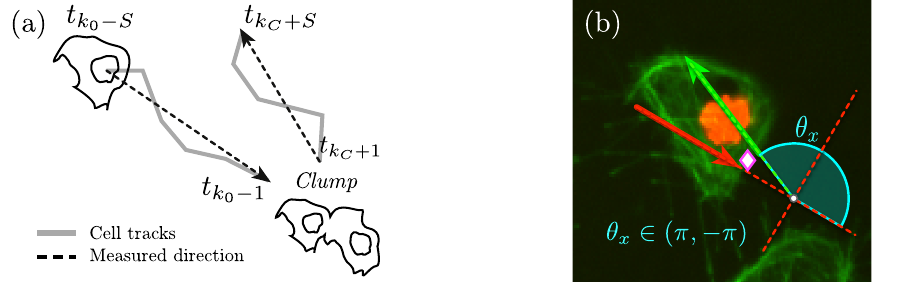
Figure 7. Illustration of the calculation of the angle of direction change ( θ x ). ( a ) Shows the determination of the direction before and after the clump ; while ( b ) displays the calculation of the angle θ x (cyan) from the previously selected lines. The red arrow represents the line generated by points at times t k t k , while the green arrow shows the points at times t k 0 − 1 Figure 8 represents the calculation of the angles compared for the interactions and the control experiments. Notice that the new axes ( x (cid:48) , y (cid:48) ) in Figure 8b can be interpreted as a new frame of reference, containing all the positions rotated and